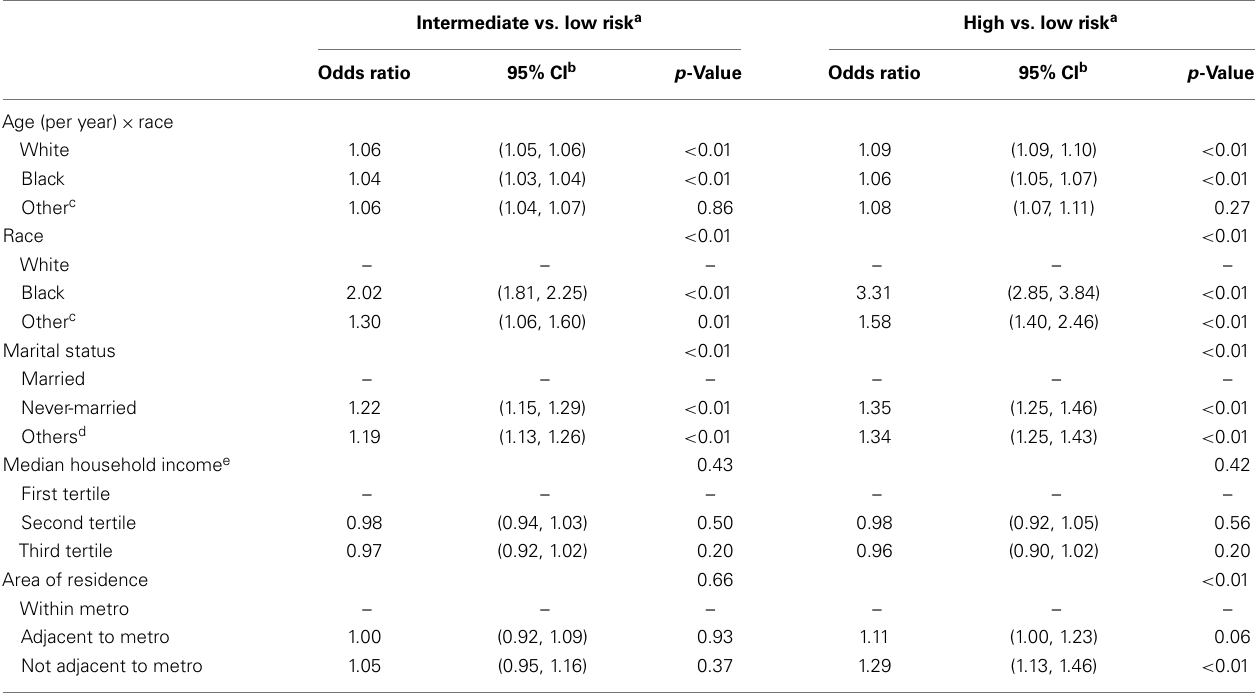
Table 4 | Multivariate logistic regression analyses modeling the probabilities of patients with intermediate-risk disease vs. low-risk disease, and of patients with high-risk diseases vs. low-risk disease respectively